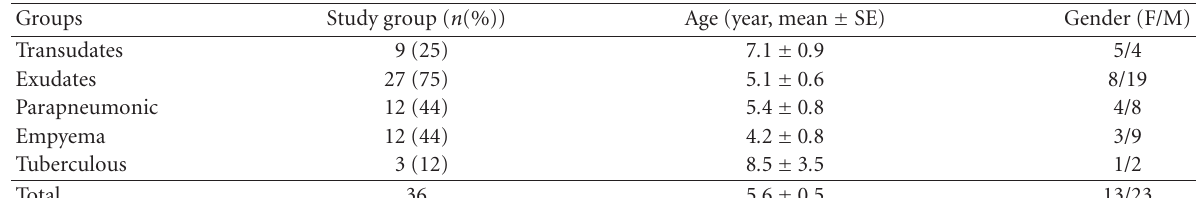
Table 1. The demographic features of all groups.